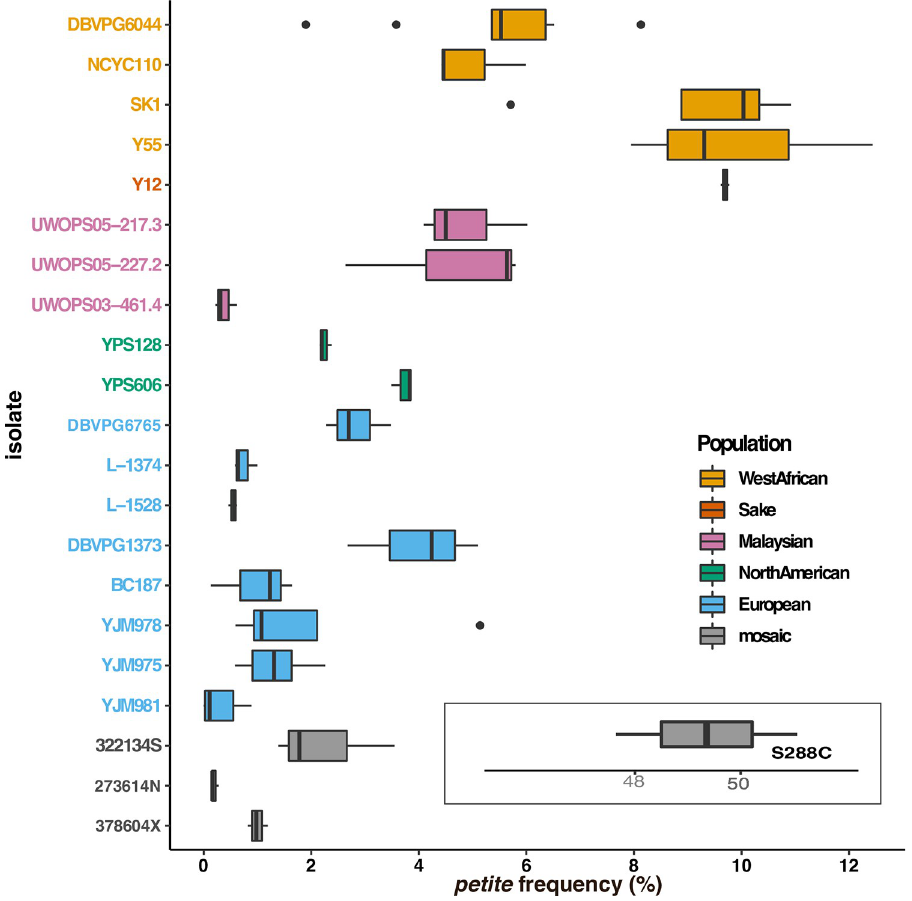
Fig 1. Genetic variation contributes to petite frequency. Boxplots showing petite frequencies (total petite colonies/ total colonies * 100) are presented for haploid derivatives of 21 wild S . cerevisiae isolates and the reference strain, S288c. Strains are colored by broad population identities from [68–70] as indicated in the key. The petite frequency for the reference strain is offset for scaling purposes. Petite frequencies differ between populations and between strains within populations (ANOVA, S2 Table